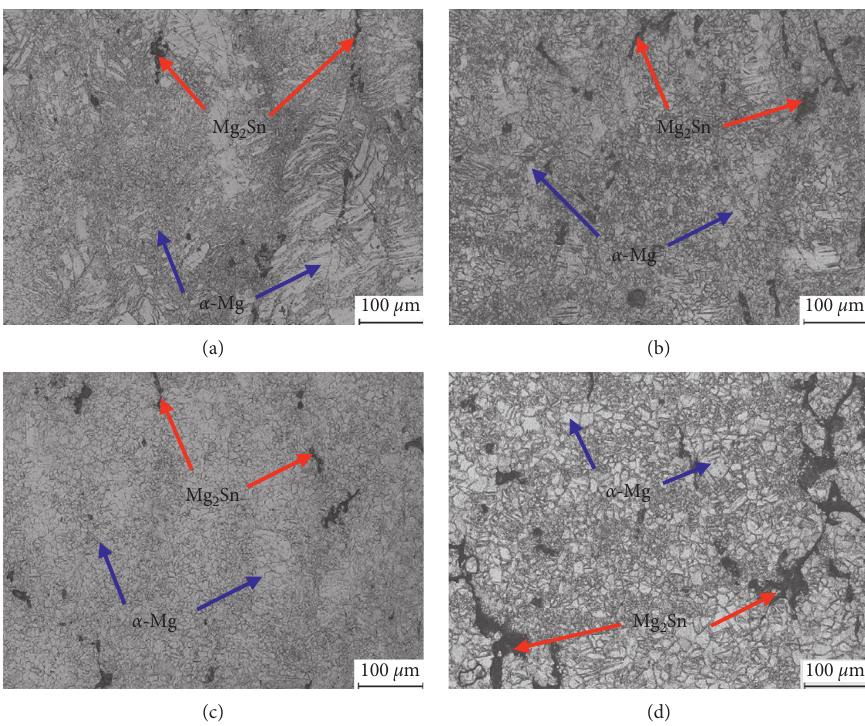
Figure 3: OM pictures of Mg-6Sn-3Al-Zn alloys rolled at different temperatures: (a) 300 ° C, (b) 350 ° C, (c) 400 ° C, and (d) 450 ° C.